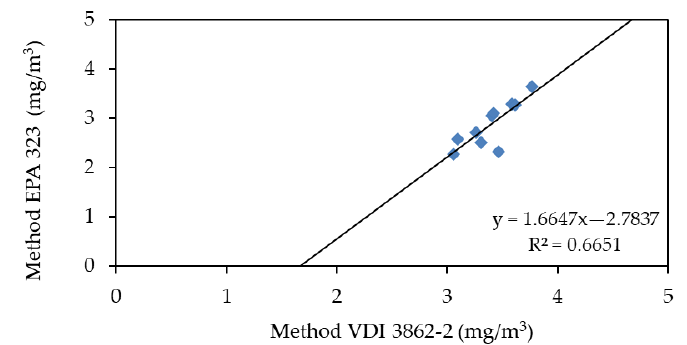
Figure 7. Correlation between EPA 323 and VDI 3862-2 analysis of samples taken by Lab. A during Second Campaign.